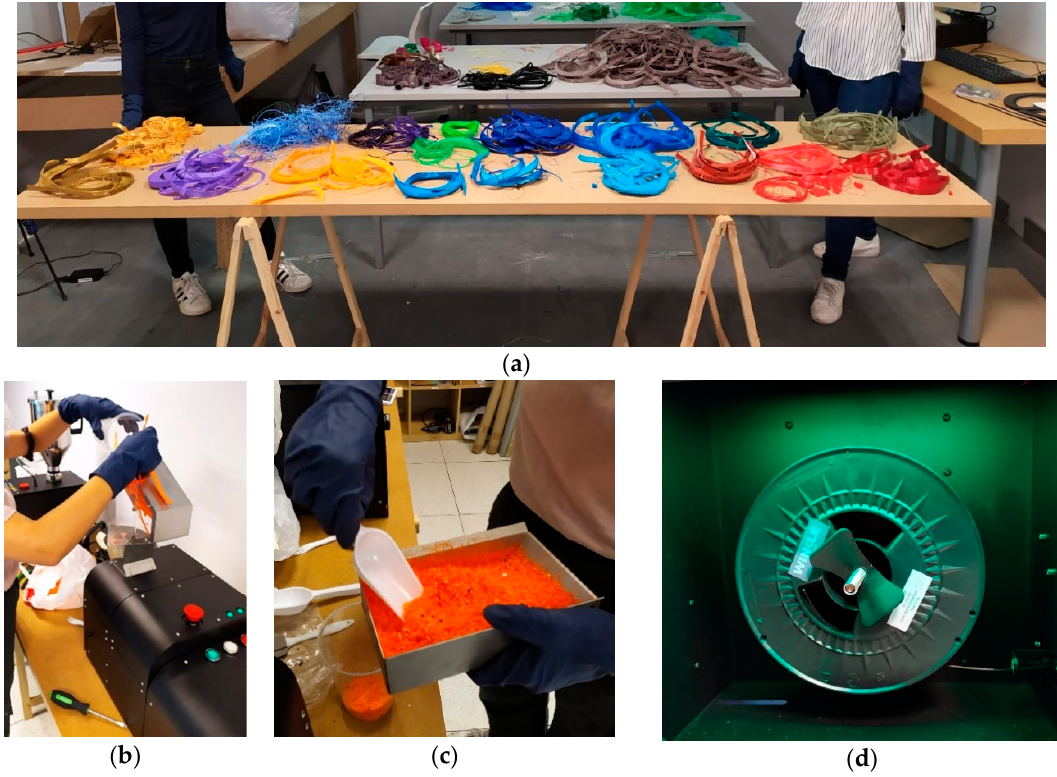
Figure 5. Manufacturing process of recycled PLA. ( a ) Color Classification; ( b ) Shredding; ( c ) Dried granulates; ( d ) Coiling the extruded filament.